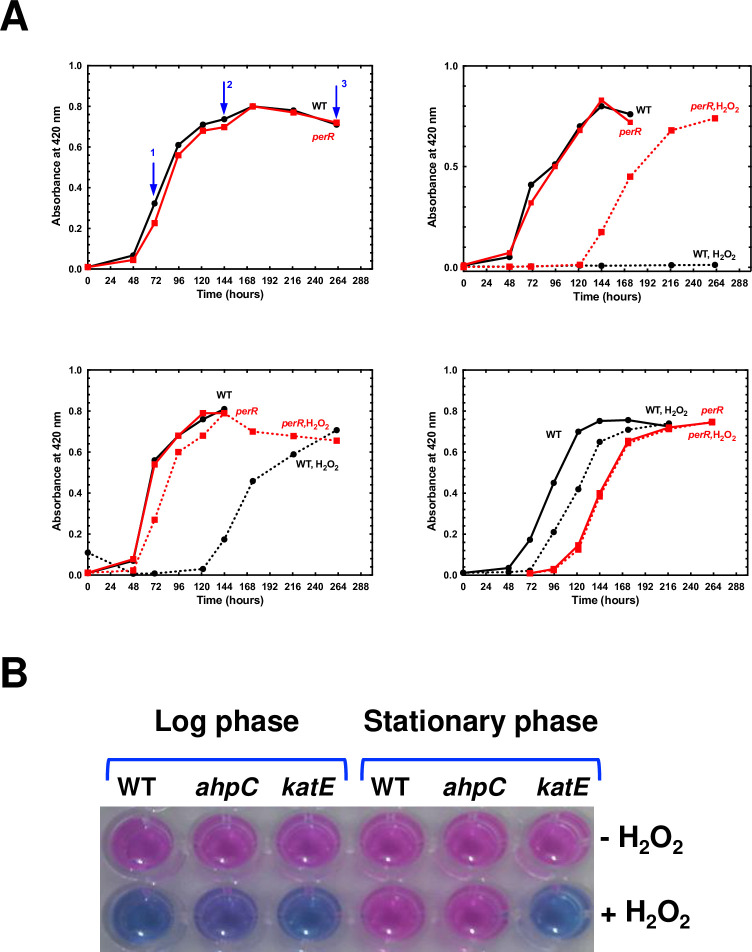
Role of catalase and AhpC in the stationary phase-adapted Leptospira tolerance to hydrogen peroxide.(A) L. interrogans WT (black line) and perR mutant (M776) (red line) strains were cultivated in EMJH medium and samples were taken at the exponential phase (at OD420 nm ≈ 0.3, left upper panel, blue arrow 1), at the entry of stationary phase (at OD420 nm ≈ 0.7, left upper panel, blue arrow 2), and at late stationary phase (at OD420 nm ≈ 0.7, 5 days after the entry in stationary phase, left upper panel, blue arrow 3) and used to inoculate a new EMJH medium in the absence (plain line) or presence of 2 mM H2O2 (dashed line). The growth curve with samples taken in the exponential phase (samples 1), in the entry of stationary phase (samples 2) and at late stationary phase (samples 3) are represented in the right upper, the left lower, and the right lower panels, respectively. (B) L. interrogans WT, katE (Man69) and ahpC (Man1368) mutant strains were cultivated in EMJH medium until the exponential or stationary phases and incubated for 30 min in the absence or presence of 10 mM H2O2. Cell viability was assessed by the ability of the cells to reduce the blue rezasurin into a pink resorufin using the Alamar Blue assay as described in the Material and Methods section.